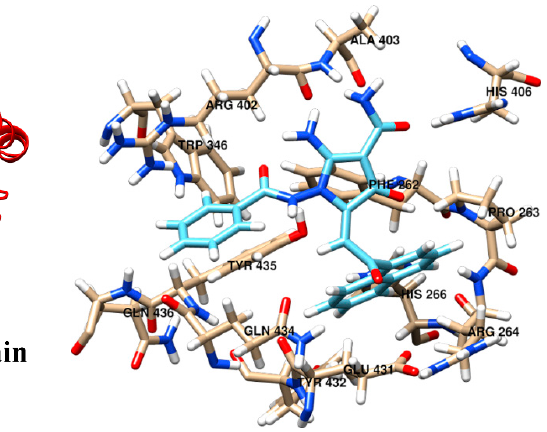
Figure 9. Lack of DNA-damaging activity of 2-APCA. ( A ) Representative images of comets from cells treated with DMSO (control), 2-APCAs (I-IV), and doxorubicin (DOX) (positive control) (scale bars = 100 µ m). ( B ) Graphic depiction of the calculated tail moment (TM) and olive tail moment (OTM) from the alkaline comet assay shown in Figure 9A. Columns, mean of at least three independent experiments with a minimum of 50 cells counted per each experiment; bars, SE. *** p < 0.001.